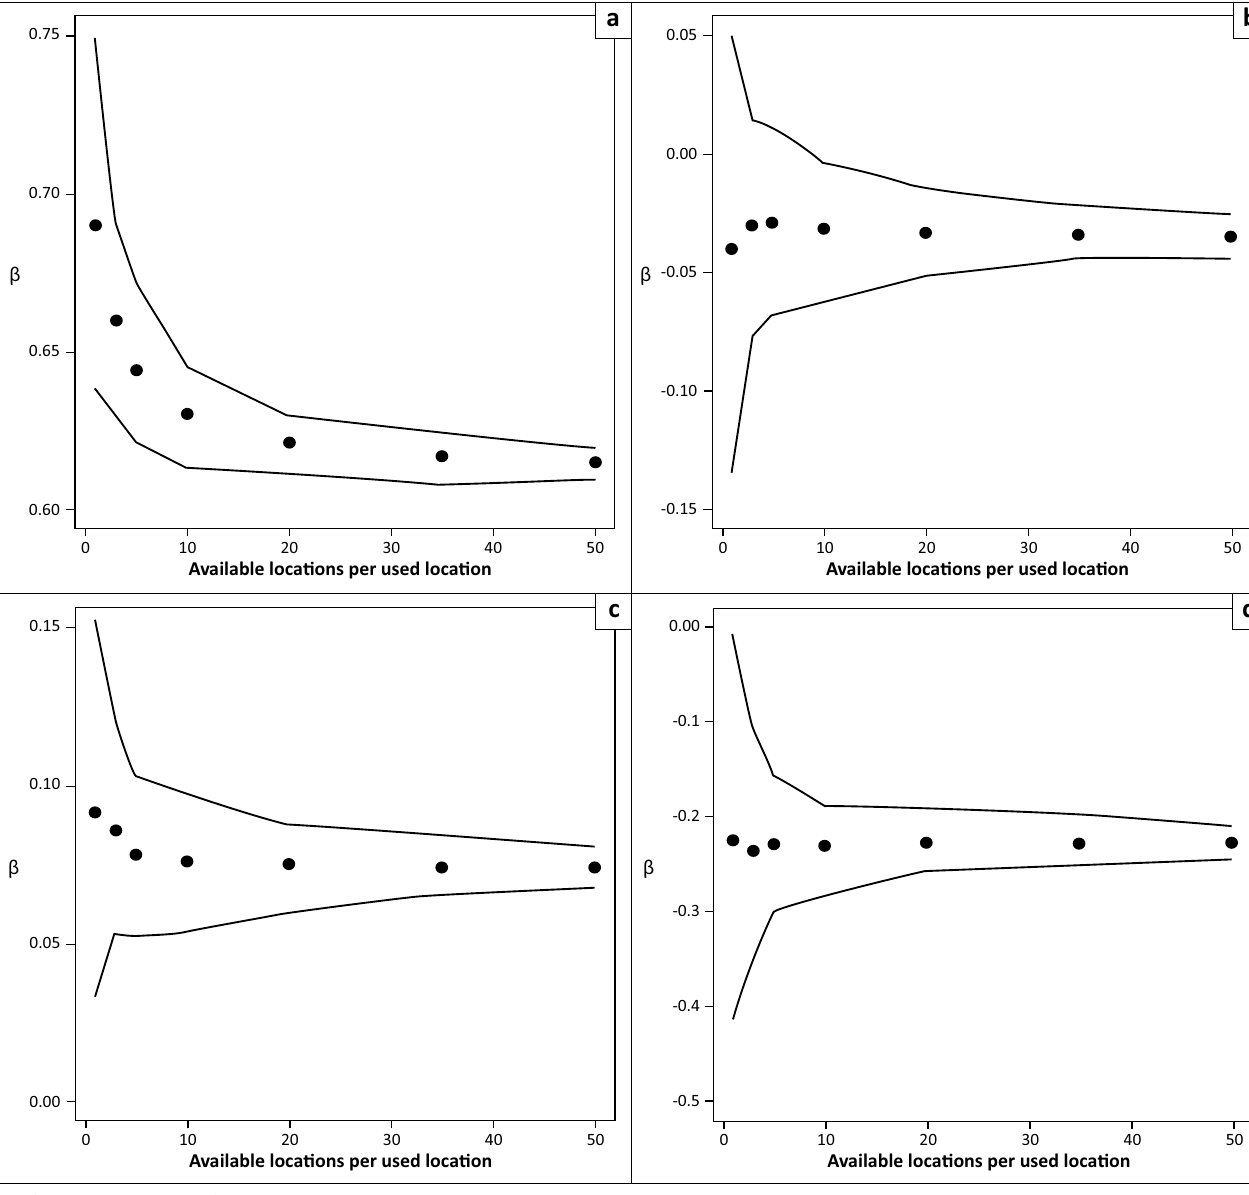
FIGURE 1-A3: Coefficient estimates (black points) and 95 % simulation envelopes (solid lines) for (a) the Normalised Difference Vegetation Index, (b) distance to water, (c) slope and (d) terrain ruggedness, calculated from 100 conditional logistic regression models fit to varying ratios of available to used elephant locations recorded at